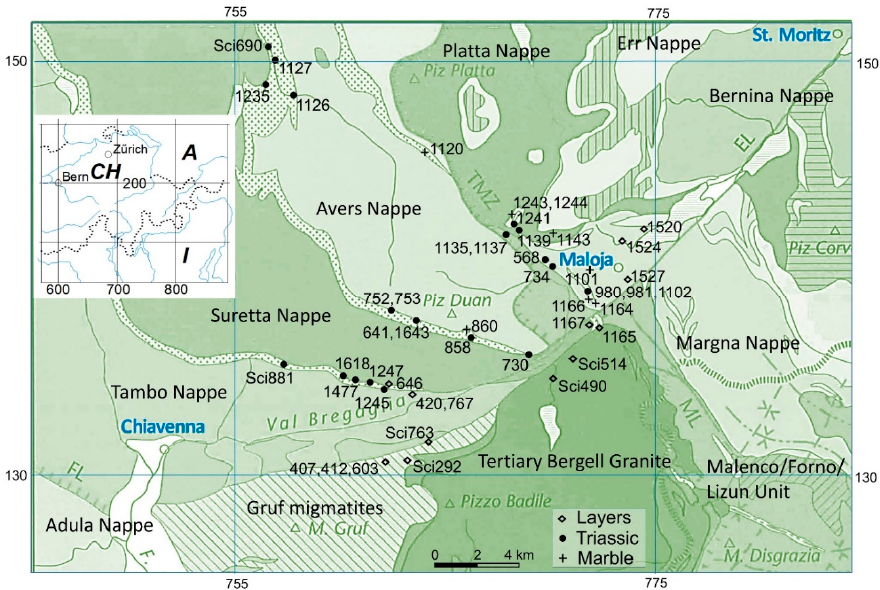
Figure 1. Tectonic map of the Bergell Alps based on Montrasio et al. [39]. Dotted zones are Triassic metasediments where quartzites and marbles were collected. Sample locations are indicated. If only numbers are given they refer to Brg (Table 1). EL: Engadine Line; ML: Muretto Line; TMZ: Turba Mylonite Zone; FL: Forcola Line. The coordinate system used in Swiss topographic maps is indicated. In the insert an overview is shown with countries (CH: Switzerland; I: Italy; A: Austria).